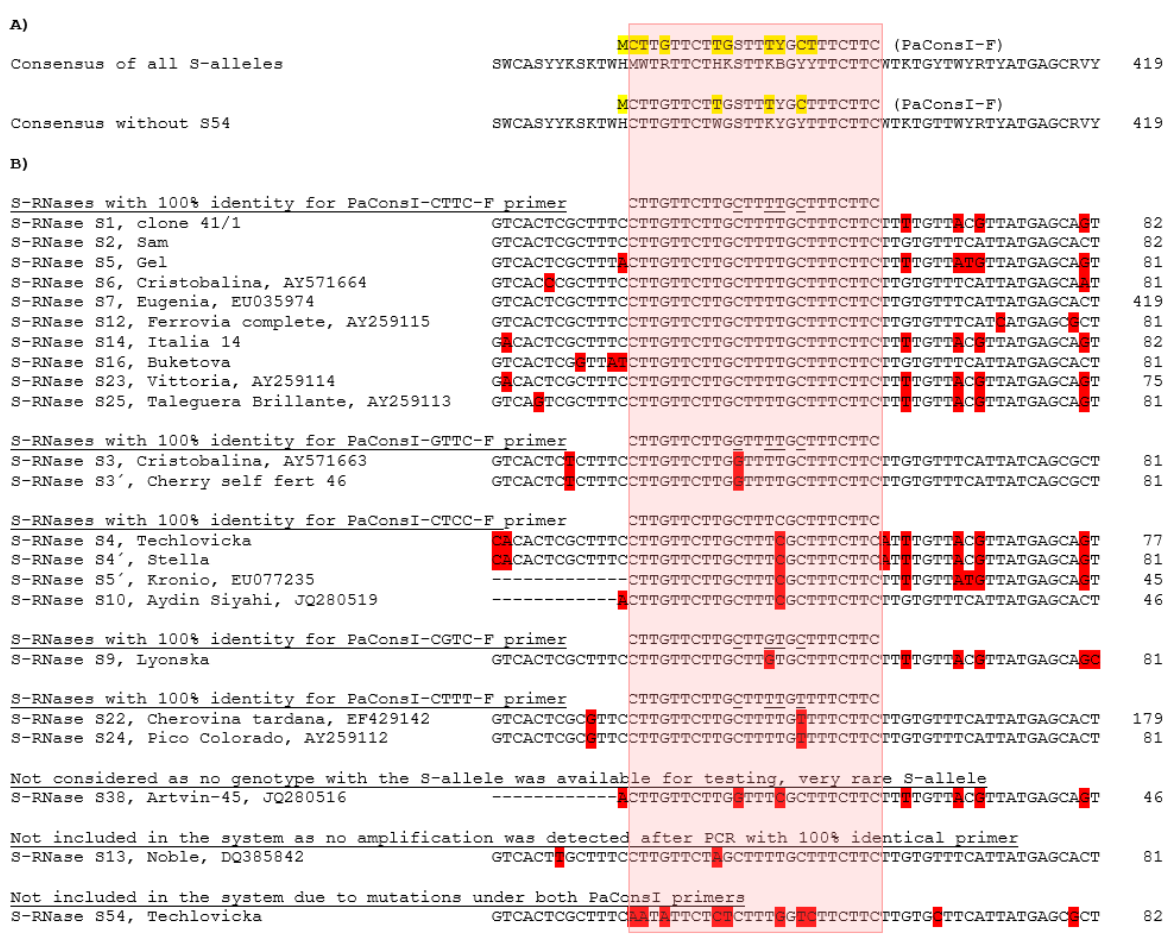
Figure 2. PaConsI-F-class primer binding site sequence analysis in detected S-alleles. The region of the primer is in the pink frame. Where used, the GenBank number is shown next to the genotype name; sequences without a reference were obtained in this study. ( A ) Upper—a consensus sequence of all S-RNases with known sequences, lower—a consensus sequence of all S-RNases with known sequences without the newly identified S54 allele (excluded due to the many mismatches present). The PaConsI-F primer sequence [19] is shown above the consensus. Nucleotides highlighted by yellow in the PaConsI-F primer are mutated in some S-alleles and were not compensated for by a previous degeneration of the primer. ( B ) S-alleles recognized by individual PaConsI-xxxx-F primers. Nucleotides highlighted in red indicate differences compared to the predominant nucleotide. Table 2. MGST- and S-allele typical fragment combinations. S-alleles with the known sequence in the region amplified by PaConsI-F and PaConsI-R are shown only. PaveIF-1A fragment size is also shown. The number of genotypes containing a respective S-allele is based on a curated list of cultivars (n = 1483; [29]) and is presented to show the coverage of the assay. B: blue detection channel (6-FAM dye); G: green detection channel (VIC dye); Y: yellow detection channel (NED dye); R: red detection channel (PET dye); N.D.: not done. The expected length is based on an existing sequence; observed length refers to a relative fragment size in fragment